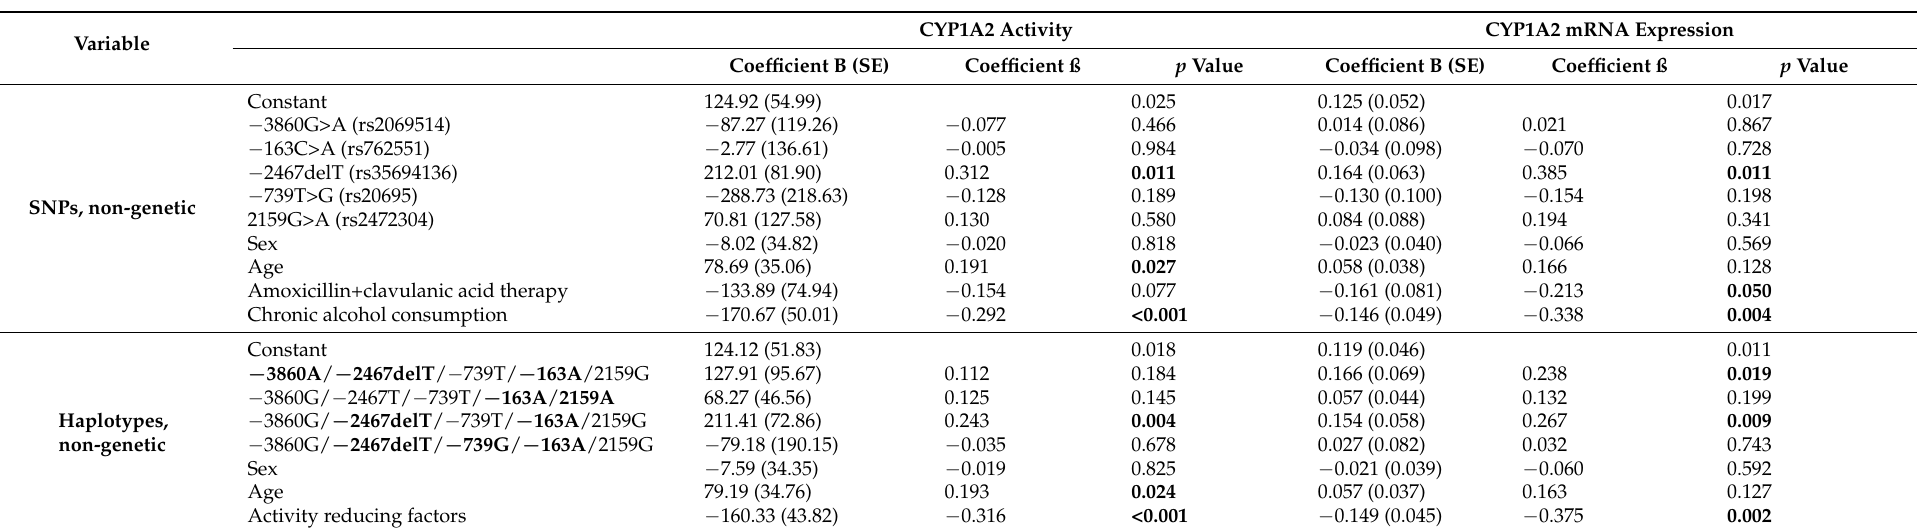
Table 3. Multivariate analysis of CYP1A2 activity (phenacetin O -dealkylation) and mRNA expression, considering genetic ( CYP1A2 SNPs or haplotypes) and non-genetic factors in liver tissue